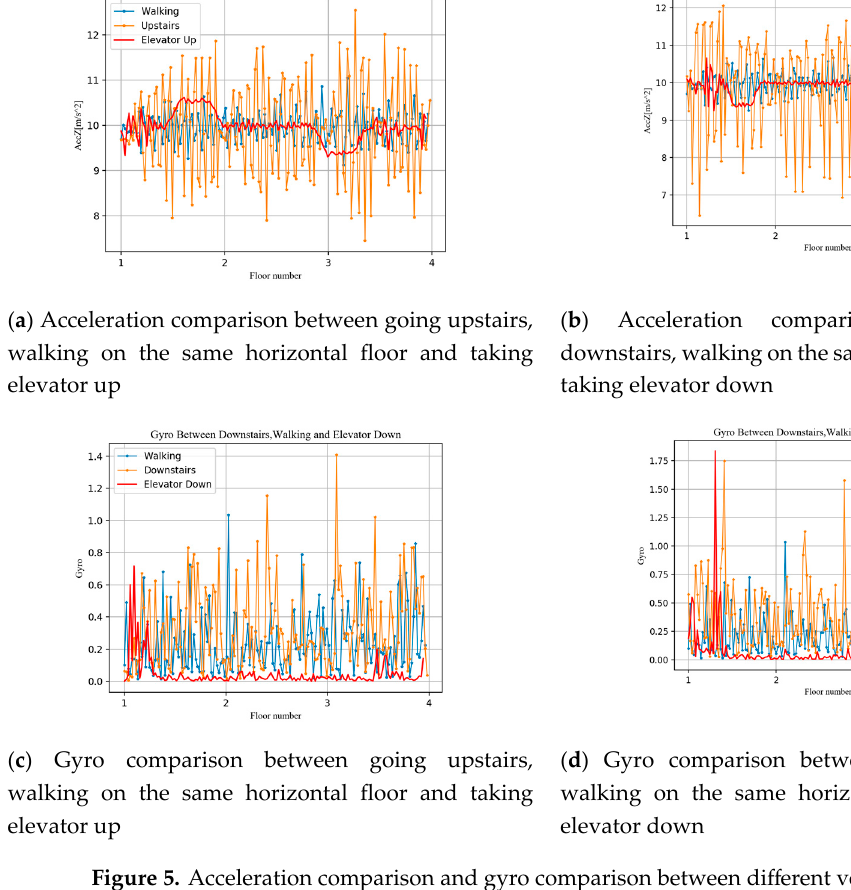
Figure 5. Acceleration comparison and gyro comparison between different vertical motion.